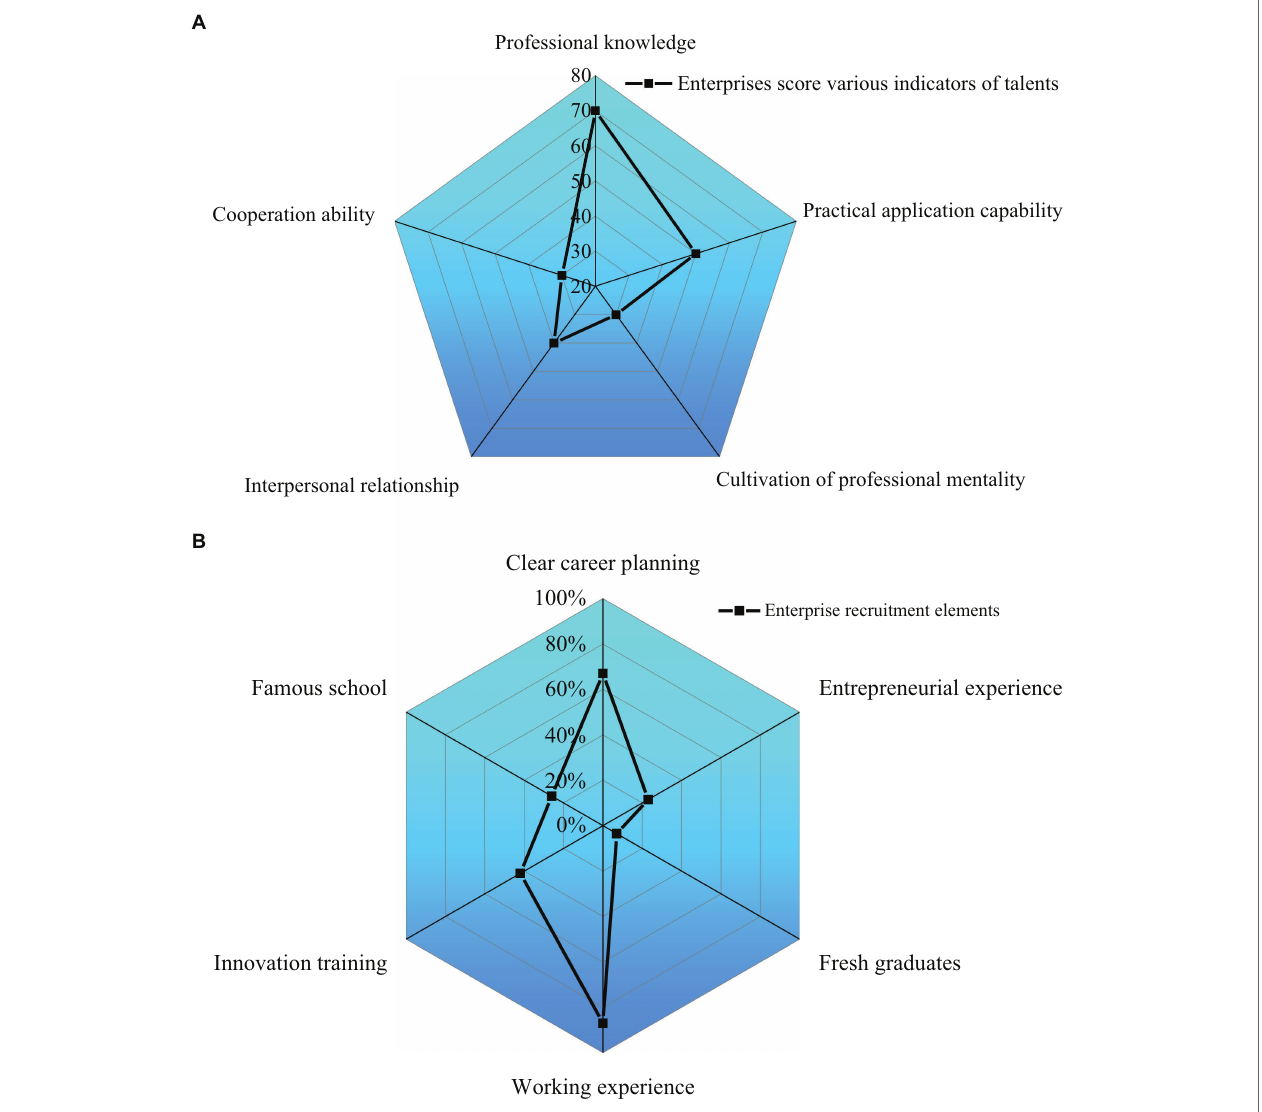
FIGURE 16 | Practical problems of talent cultivation. (A) Enterprise talent evaluation indexes and (B) factors of enterprise